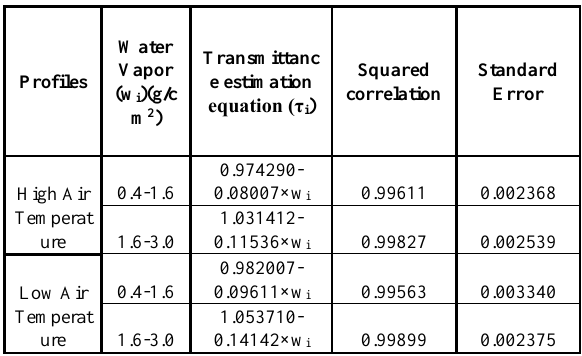
Table 1. Estimation of atmospheric transmittance from water